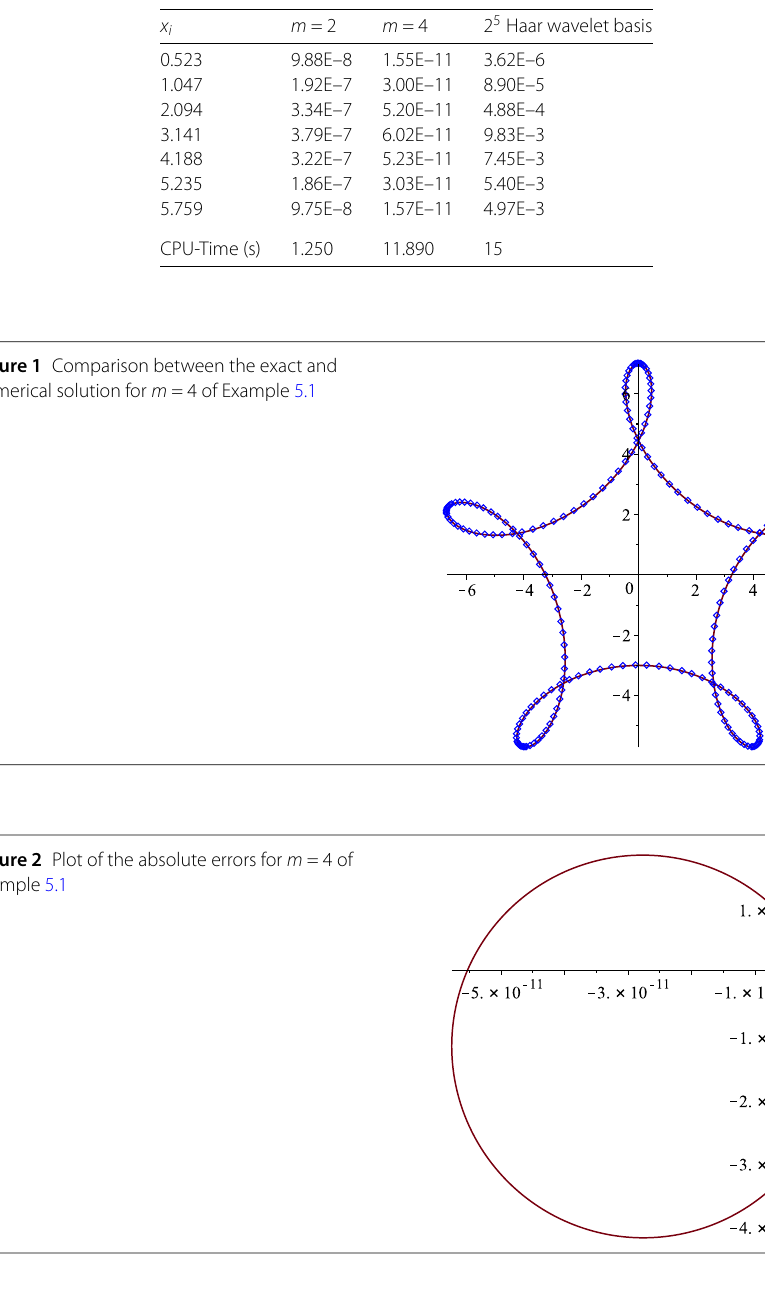
Table 1 Numerical results of Example 5.1